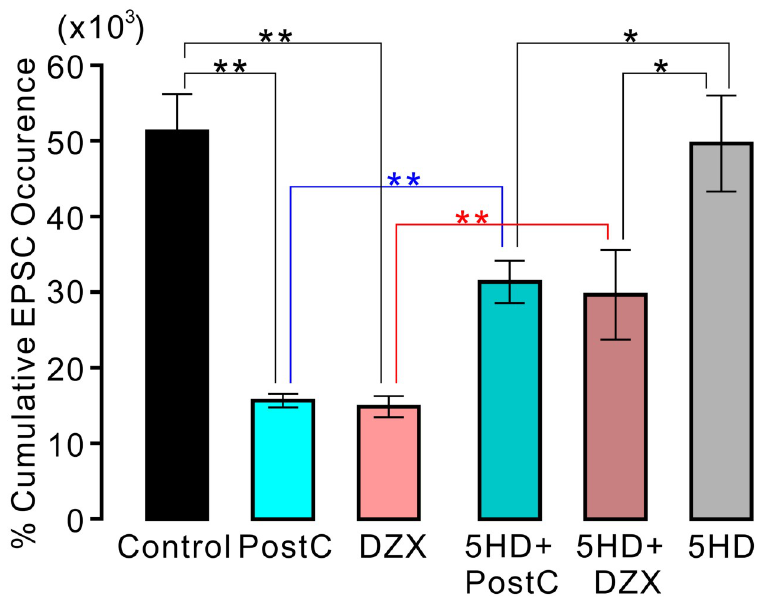
Fig 5. Effects of postconditioning and diazoxide application on cumulative EPSC occurrence. Each vertical rectangle and error bar indicate percent cumulative EPSC occurrence at 20 min after onset of ischemic perfusion (12.5 min after reperfusion) and SEM, respectively. For all the groups, the number of data is ten. Asterisks indicate significant difference in post-hoc pairwise comparisons ( �� : p < 0.01, � : p < 0.05).